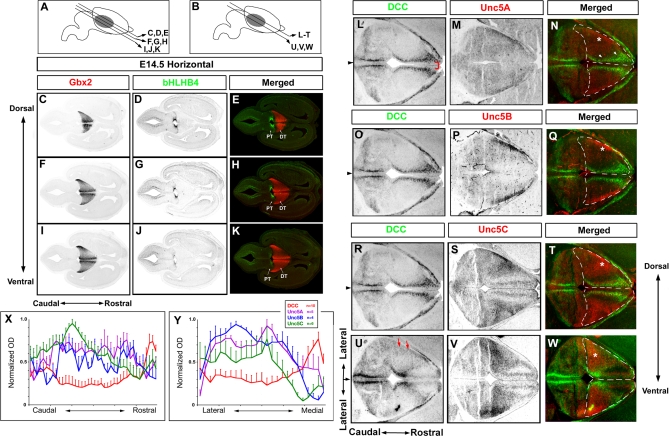
Patterns of Expression of Netrin-1 Receptors in the Mouse Dorsal Thalamus(A and C–K) At E14.5, mRNA in situ hybridization (ISH) for Gbx2 delineates the DTh along its rostrocaudal axis on horizontal sections distributed along the doesoventral axis of the DTh ([C, F, and I]; see levels of section in [A]).Expression of bHLHB4 on adjacent sections delineates the pretectum (PT) (D, G, and J). When merged (E, F, and K), Gbx2 and bHLHB4 show nonoverlapping and complementary expression at the diencephalic–mesencephalic boundary delineating the caudal limit of the DTh (DT) on E14.5 horizontal sections.(B and L–W) In situ hybridization for DCC ([L, O, R, and U], green in [N, Q, T, and W]), Unc5A ([M], red in [N]), Unc5B ([P], red in [Q]), and Unc5C ([S and V], red in [T and W]) on adjacent horizontal sections of E14.5 mouse embryos isolated at two levels of sections along the dorsoventral axis of the DTh (B). DCC is expressed most highly in a rostromedial domain of the DTh in postmitotic regions (unpublished data) and is excluded from the thin ventricular zone left at this time (bracket in [L]). Conversely, Unc5A, Unc5B, and Unc5C are all expressed in nonoverlapping caudolateral domains of the DTh (stars in [N, Q, T, and W] indicate the approximate peak of expression). The dashed lines in (N, Q, T, and W) correspond to the actual limit of the DTh as defined by Gbx2 expression on adjacent sections (see [I–K]). Note that DCC is expressed at low, but significant, levels in the caudolateral domain of the DTh (red arrows in [U]) where it is coexpressed with Unc5C (star in [V]).(X and Y) Quantification of the gradient of DCC (n = 10), Unc5A (n = 5), Unc5B (n = 4), and Unc5C (n = 6 sections) mRNA expression along the rostrocaudal axis (X) and the mediolateral axis (Y) of the DTh at E14.5 as indicated by the lines in (L). Gradients were measured by normalizing the optical density values on multiple adjacent sections (number indicated in [Y]) shown in (L–W).Arrowheads in (L, O, R, and U) indicate the midline.